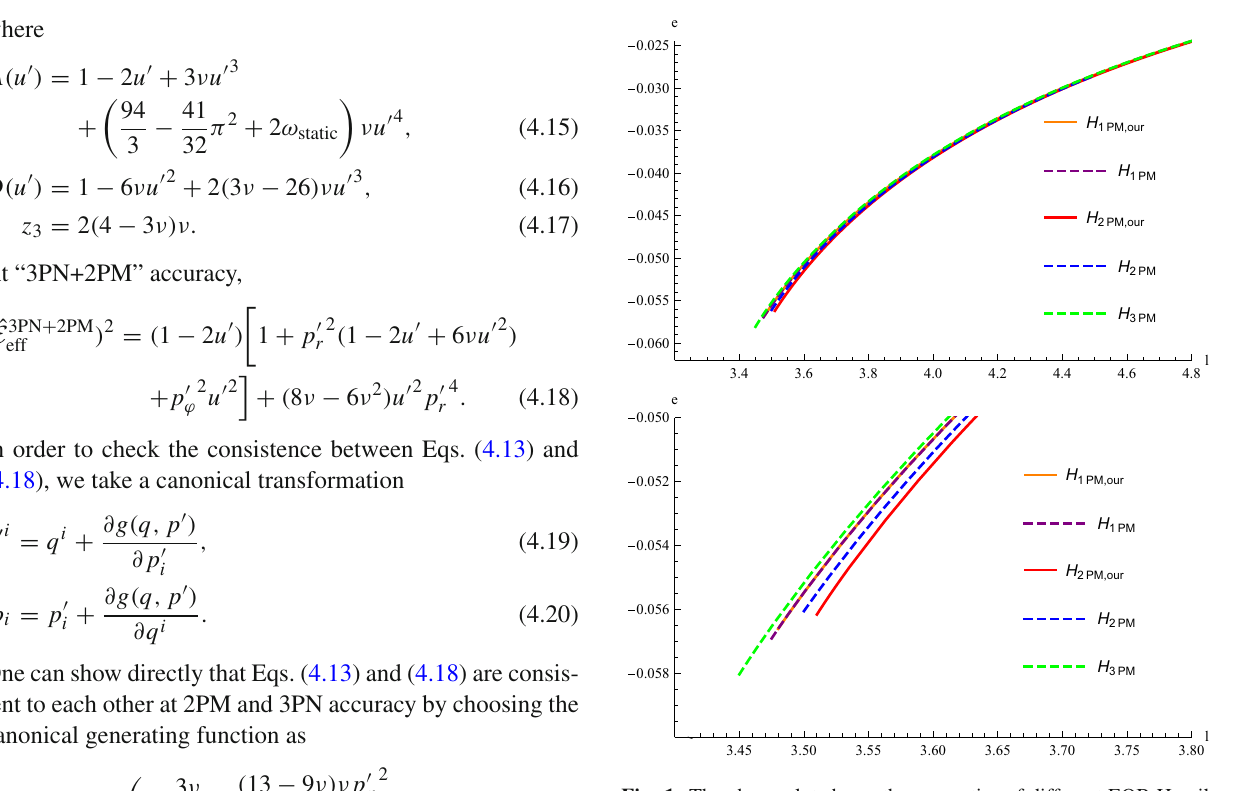
Fig. 1 The above plot shows the energetics of different EOB Hamil- tonians. H 1PM , our and H 2PM , our mean the 1PM and 2PM results got in the current work. H 1PM [38], H 2PM [38] and H 3PM [39] are the existing results. The bottom plot corresponds to the zooming in for the l ∈ ( 3 . 45 , 3 . 65 )